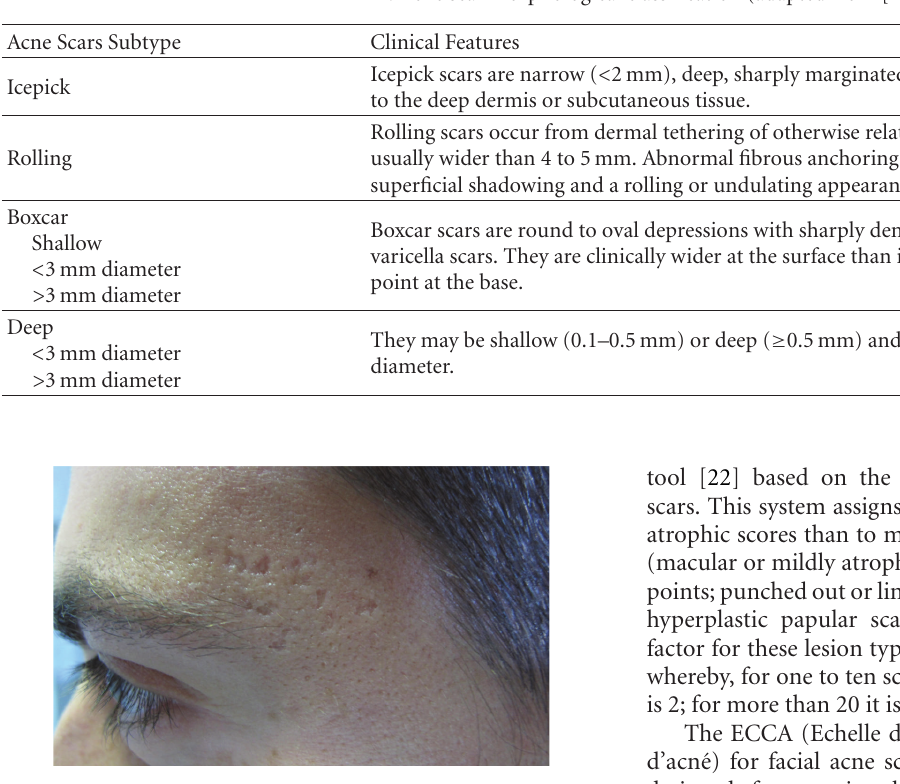
Figure 3: Boxcar